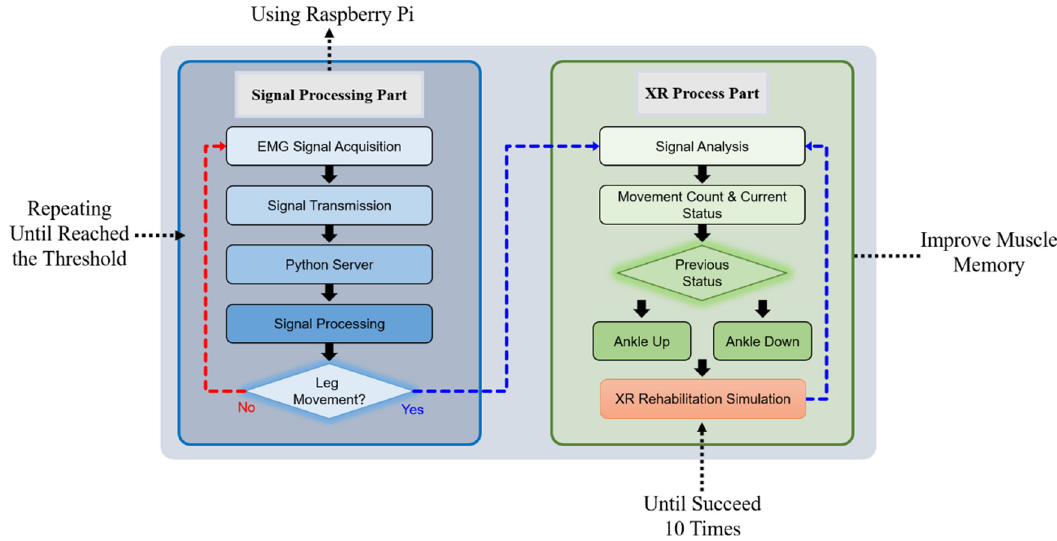
Figure 2. The Process of the Rehabilitation Program.